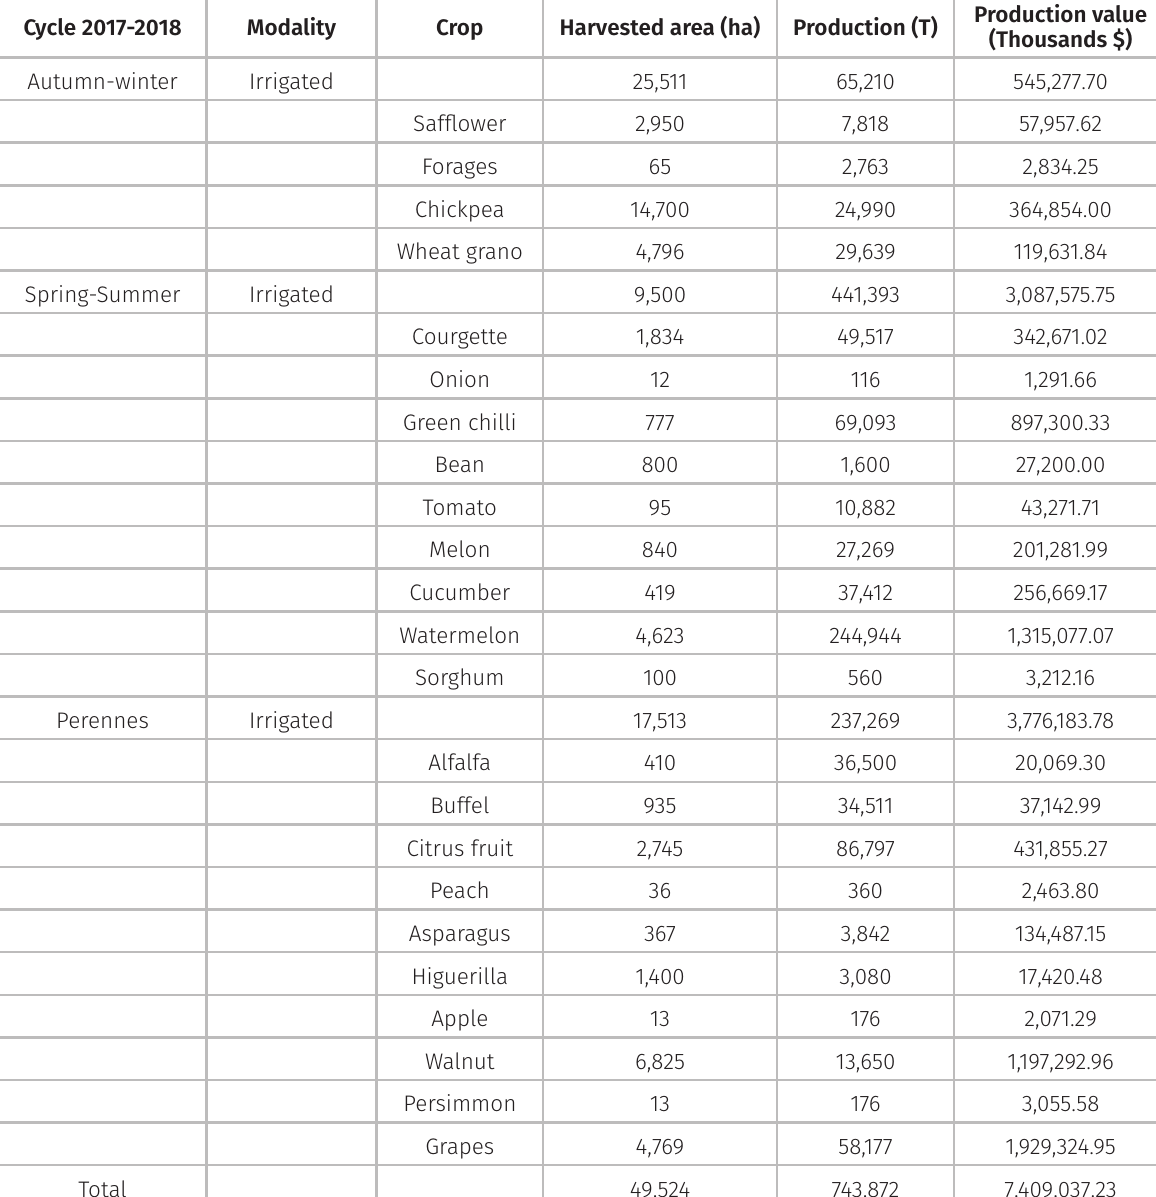
Table I. Irrigation District 051 Hermosillo Coast